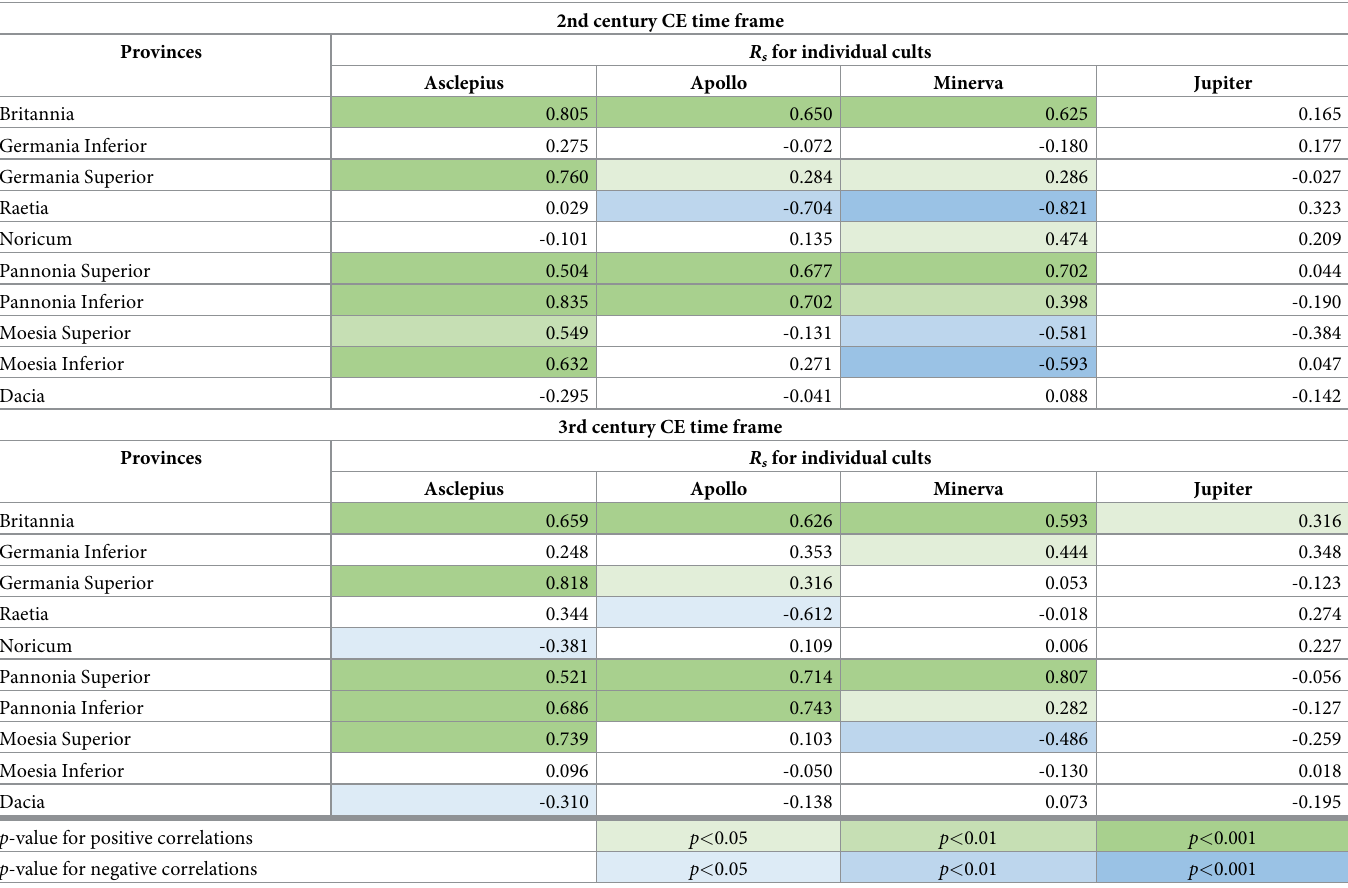
Table 4. Spearman correlation ( R s ) between distances from positions of Roman soldiers to their nearest proxy for the presence of a Roman physician and their near- est cult inscription, based on the data that can be dated to the 2nd and 3rd century